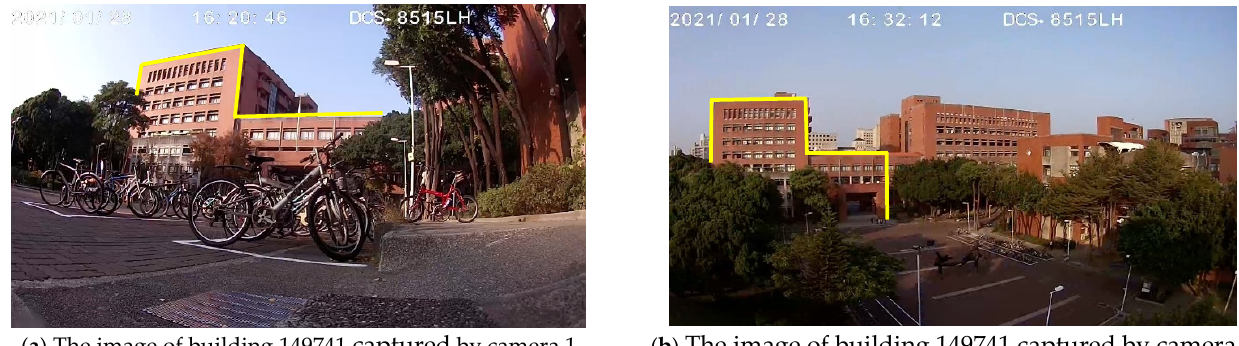
Figure 17. The specified building and the images respectively captured by the two cameras (a) Camera1 (b) Camera2. Table 5. Visibility index of CCTV and visible objects.